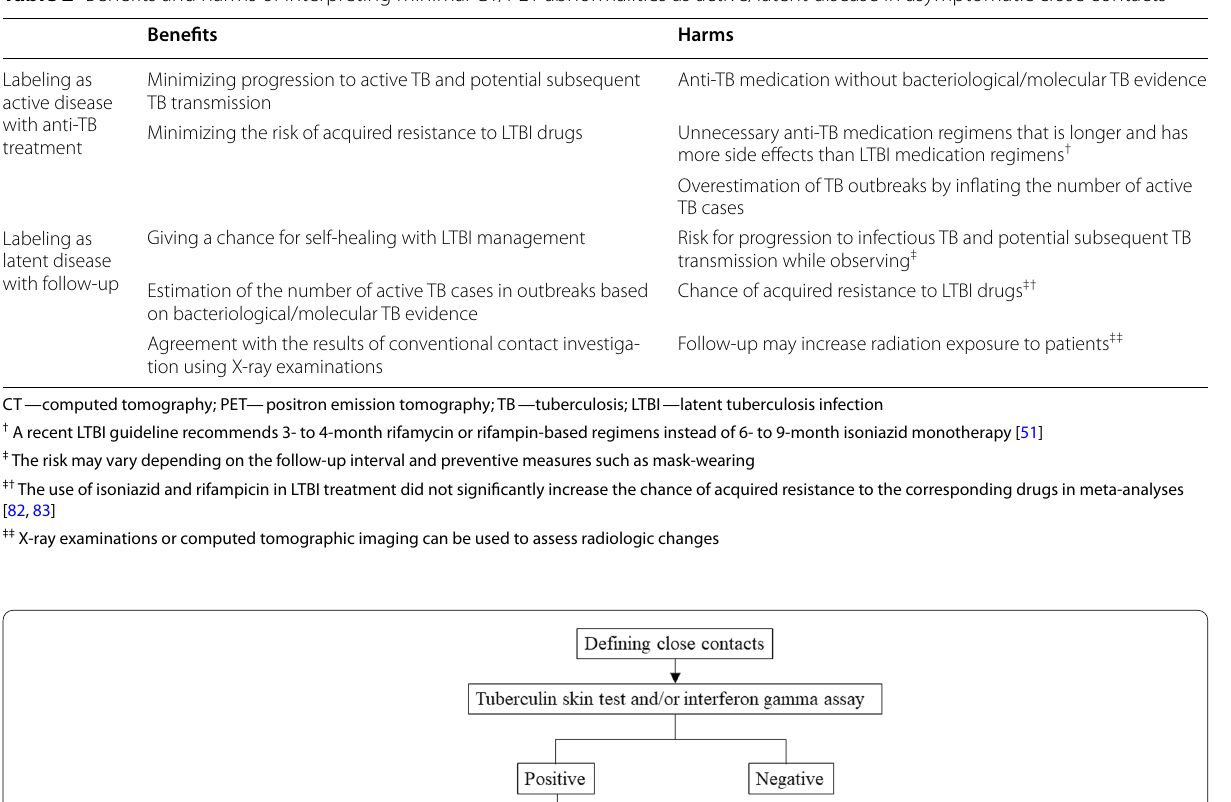
Table 2 Benefits and harms of interpreting minimal CT/PET abnormalities as active/latent disease in asymptomatic close contacts